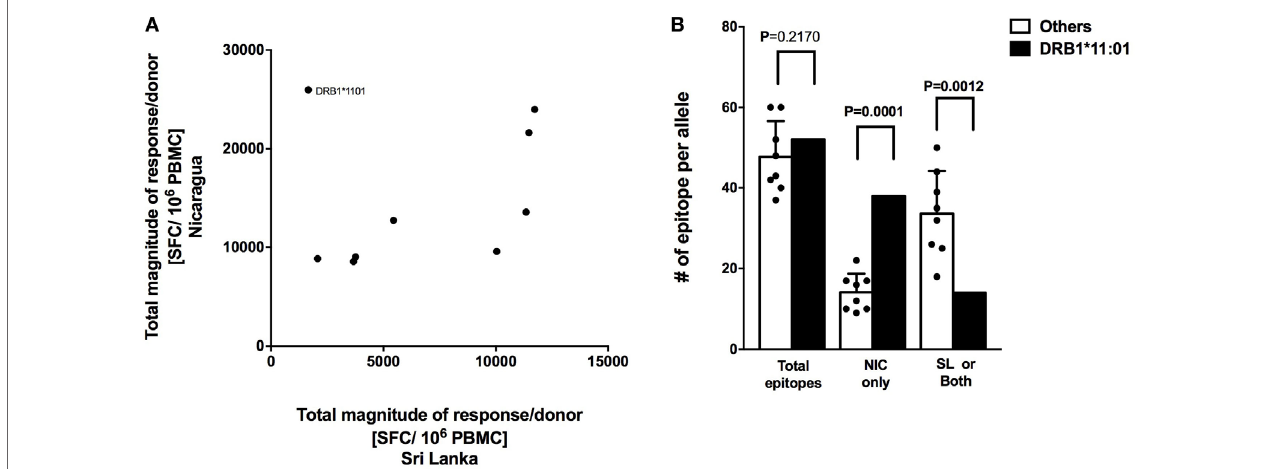
FigUre 3 | Correlation of HLA-restricted CD4 + T cells responses in Nicaragua and Sri Lanka cohorts. (a) Correlation of total responses magnitude per donor as a function of restricting HLA molecule, between Nicaraguan and Sri Lankan cohorts ( R 2 = 0.07291, p = 0.4823; if HLA-DRB1*11.01 is removed, R 2 = 0.5537, p = 0.0343). (B) Comparison of the number of epitopes detected in the case of the HLA-DRB1*11:01 allele and in other eight HLA-DRB1 alleles (*01:01, *03:01, *04:03, *07:01, *08:02, *09:01, *13:01, and *15:01) considered in the study using one-sample t test. Bars refer to total epitopes, epitopes detected only in Nicaragua (NIC), and epitopes detected in Sri Lanka (SL) only or both